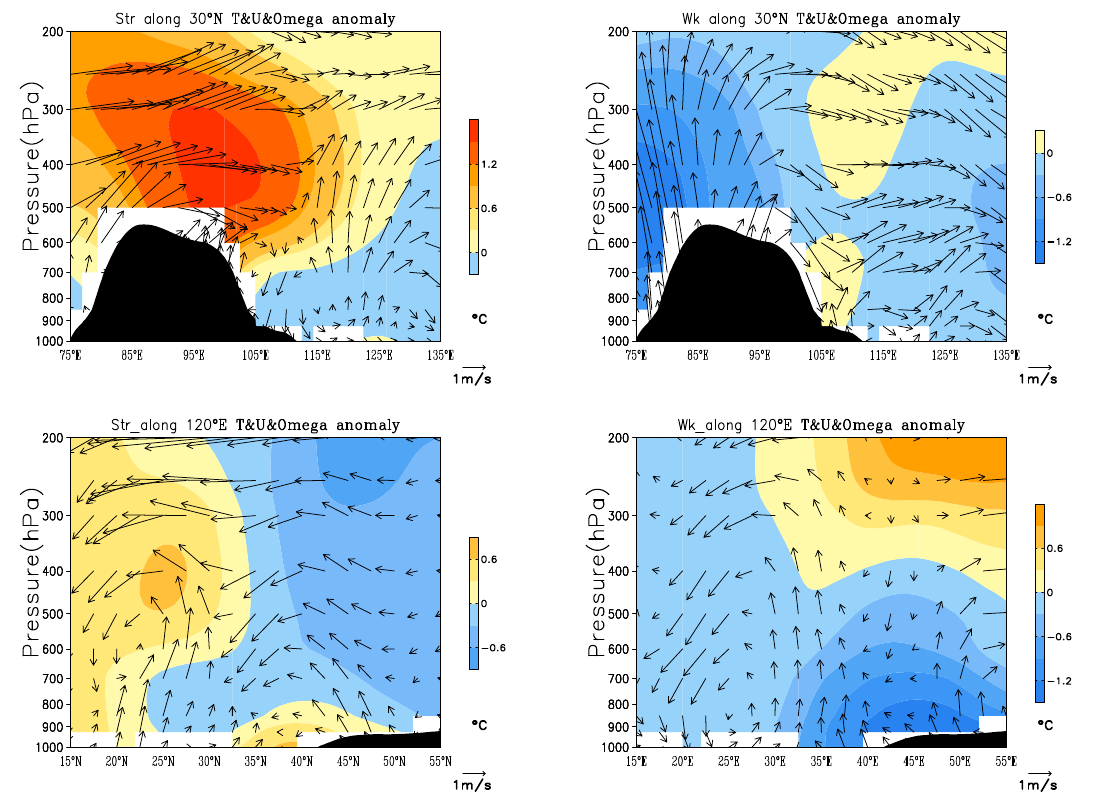
Figure 8. Circulation and temperature fields in the east-west ( top ) and north-south ( bottom ) cross- sections of the Yangtze River Delta region in strong ( left ) and weak ( right ) cold source years on the Qinghai-Tibet